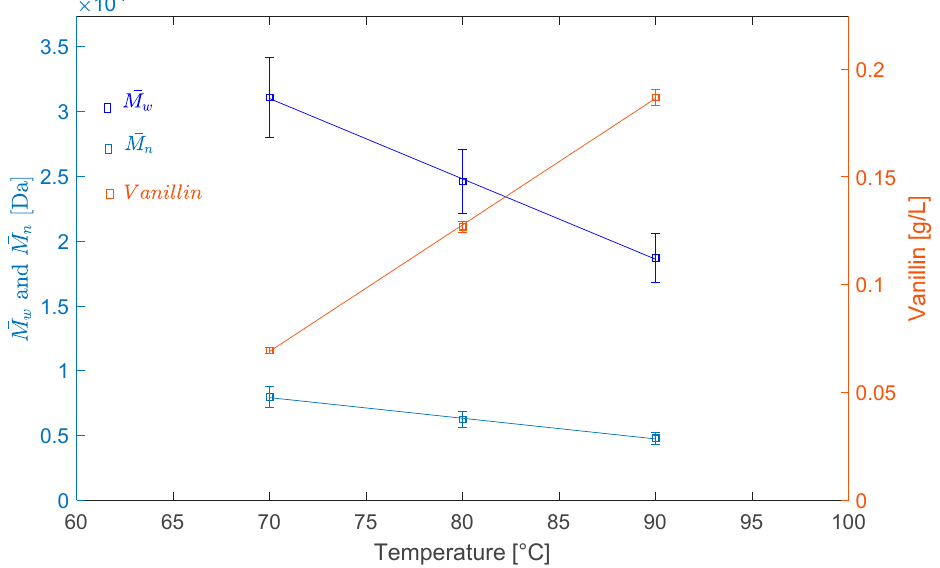
Figure 4. Effects of temperature on the LS average molecular weight and vanillin concentration in the solution.